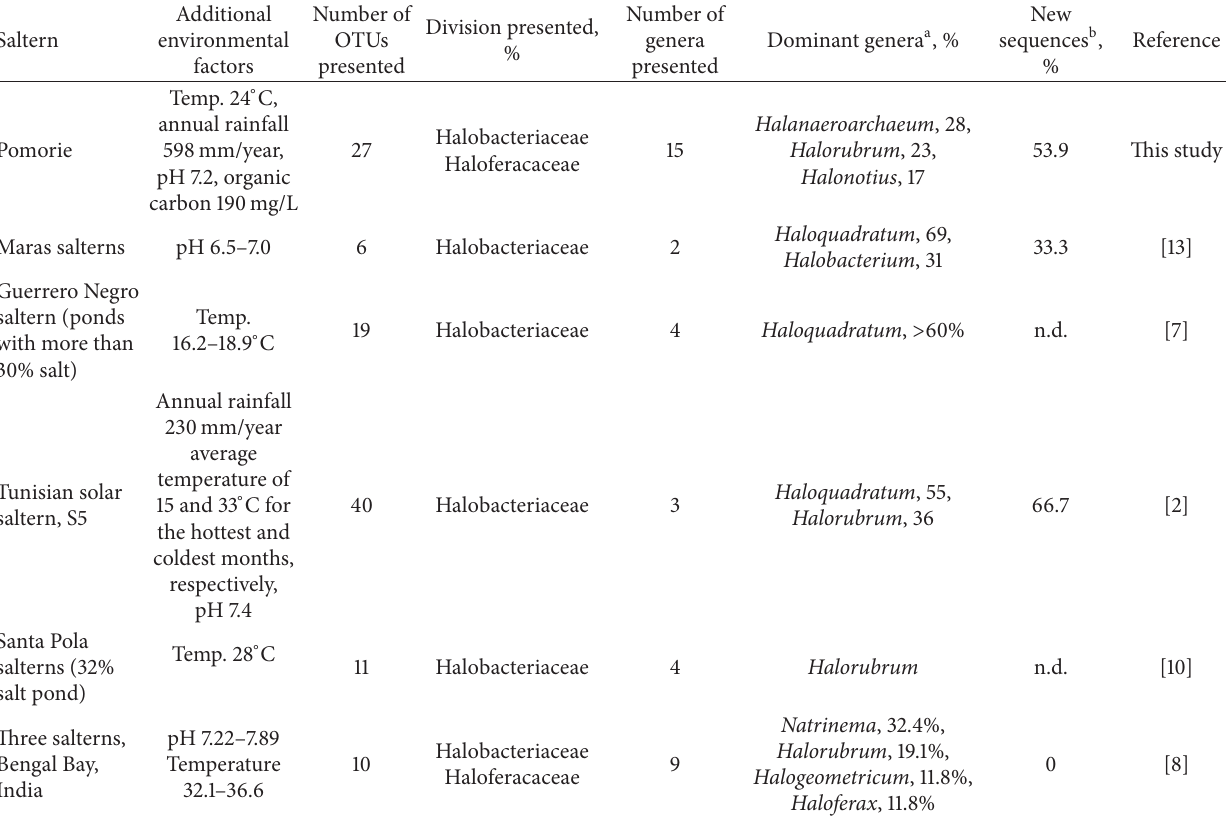
Table 2: Comparison of the archaeal diversity in Pomorie saltern and other thalassohaline hypersaline ecosystems.